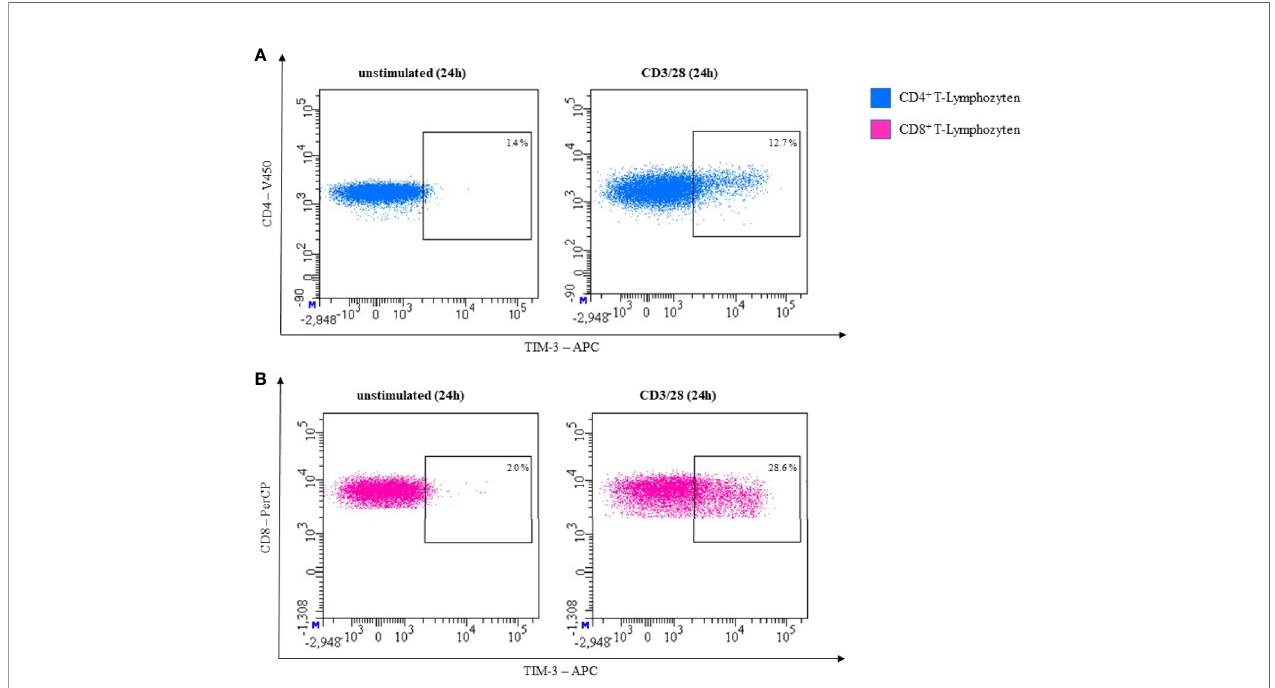
FIGURE 6 | Representative fl ow cytometric analysis of TIM-3 expression on T helper cells (CD4 + ) (A) and cytotoxic T cells (CD8 + ) (B) . Comparison of unstimulated (left) and CD3/28 stimulated results after 24h (right) (healthy donor, male, 23 years